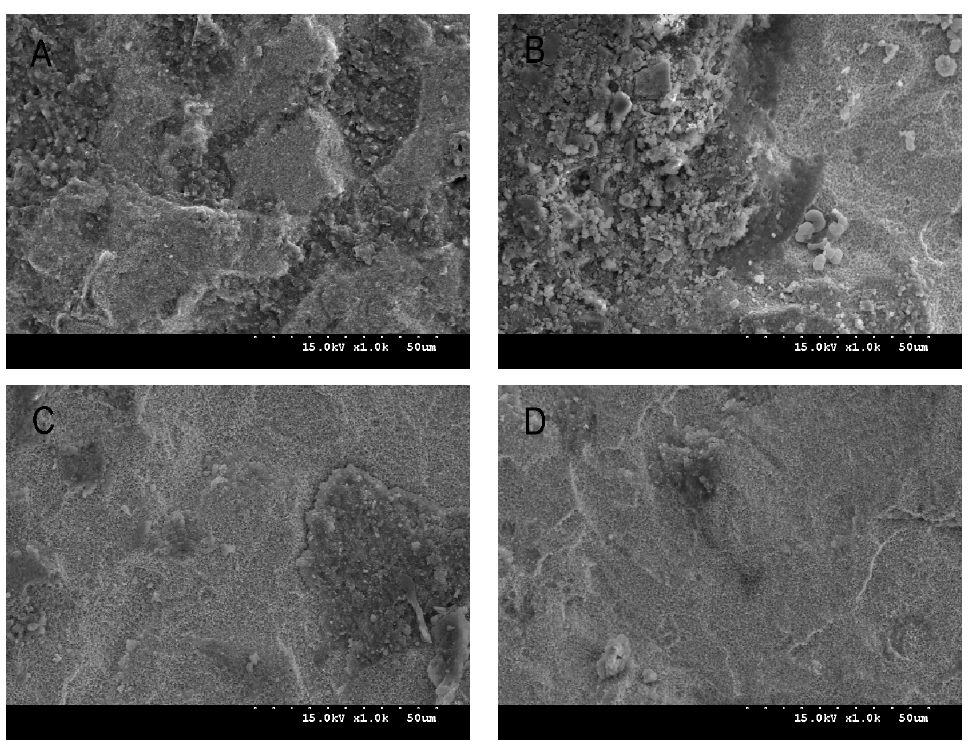
Figure 5. FE-SEM photograph ( × 1000 magnification) of cement residues ( A ) 40HF1 bonded with Panavia F 2.0 without thermocycling; ( B ) 40HF2 bonded with Panavia F 2.0 without thermocycling; ( C ) 40HF2 bonded with Variolink N without thermocycling; ( D ) 40HF2 bonded with Variolink N with thermocycling.